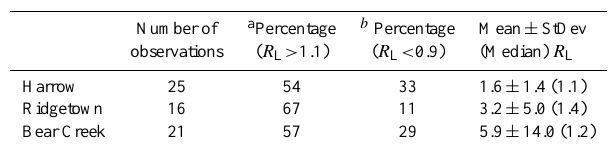
Table 4. The ratio ( R L ) of 30-min average particle number concen- trations during lake breezes to averages prior to the